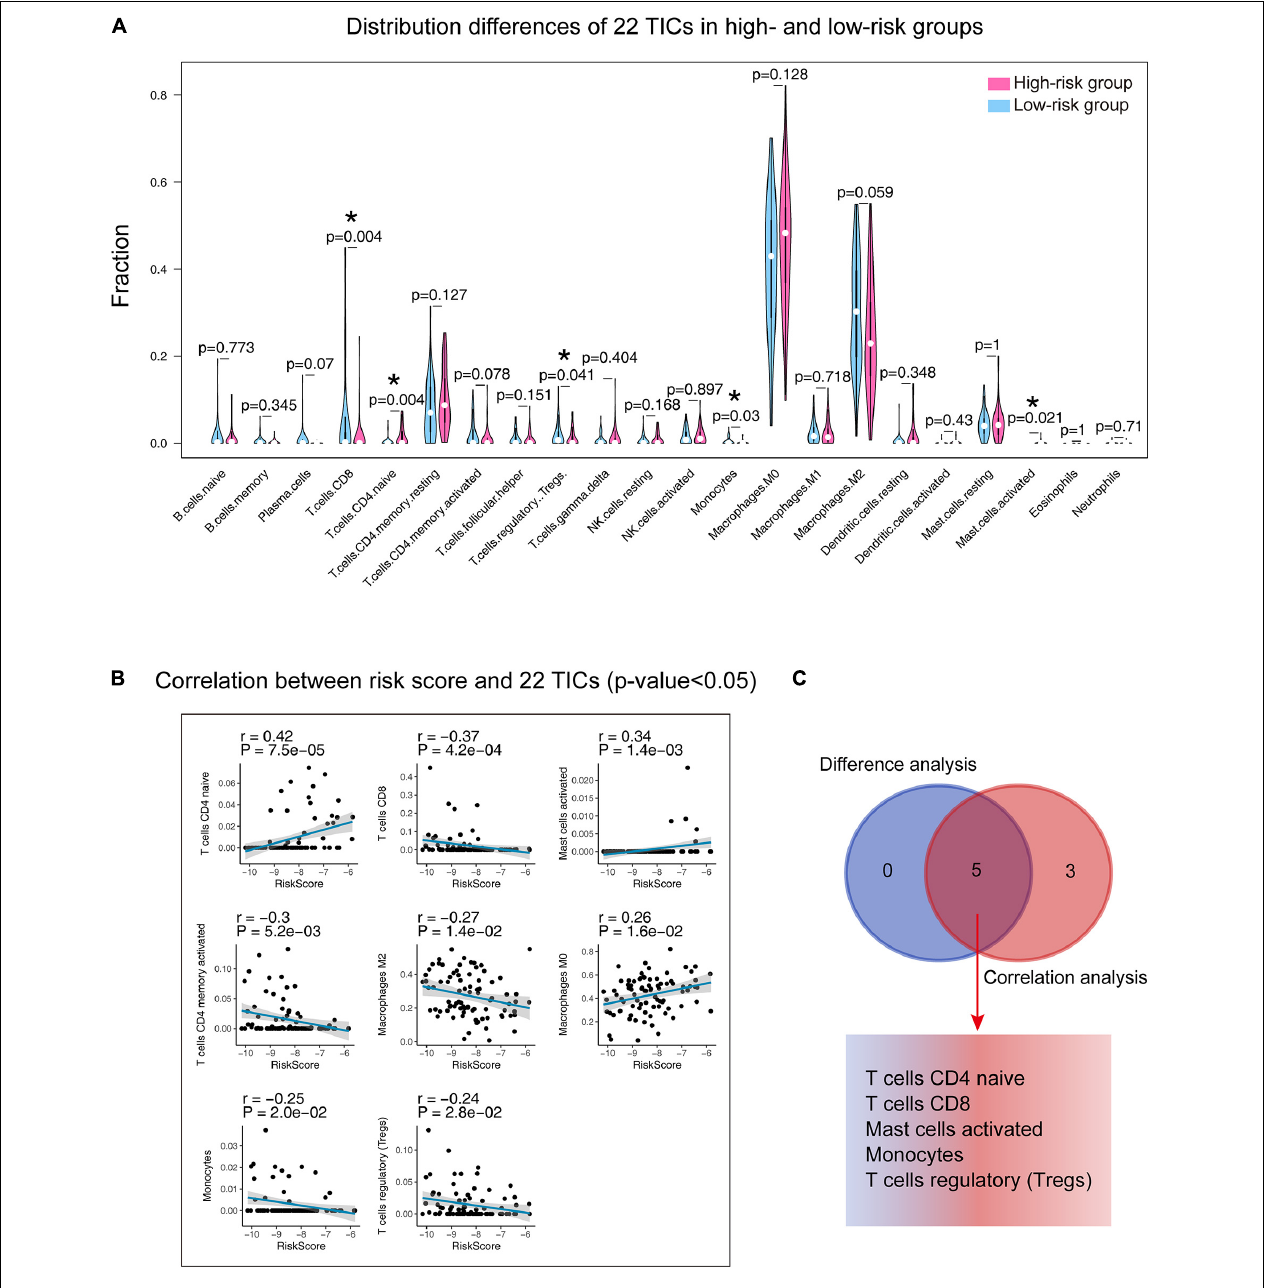
FIGURE 10 | Integrating analysis for identifying the relationship between 22 TICs and the nine-gene signature. (A) Wilcoxon rank-sum was adopted to test the differences in each TIC distributed in the high- and low-risk groups. (B) The Spearman coefficient examines the correlation between each TIC and the nine-gene signature. Only correlations with p -value < 0.05 were plotted.The blue line displays the trend of the TIC and risk score. The shading besides the blue line characterizes the 95% CI. (C) Venn diagram integrating the results from (A) and (B) . TIC: tumor-infiltrating immune cell; *: p -value < 0.05; CI: confidence interval; p -value < 0.05 was considered statistically